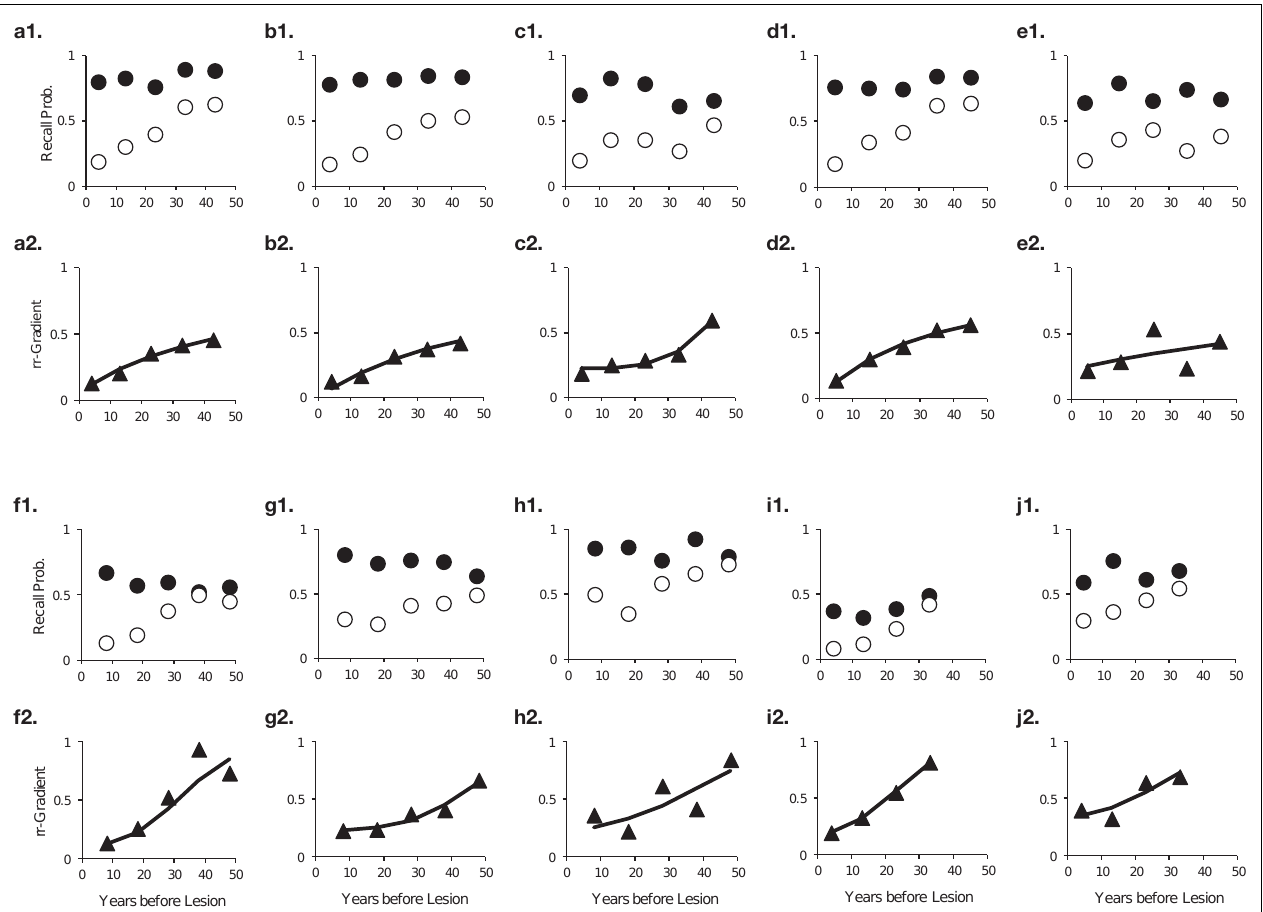
measured data (solid circles are controls, open circles are patients), and 2 the data transformed to a relative retrograde gradient (always shown as triangles, with the solid line indicating the model